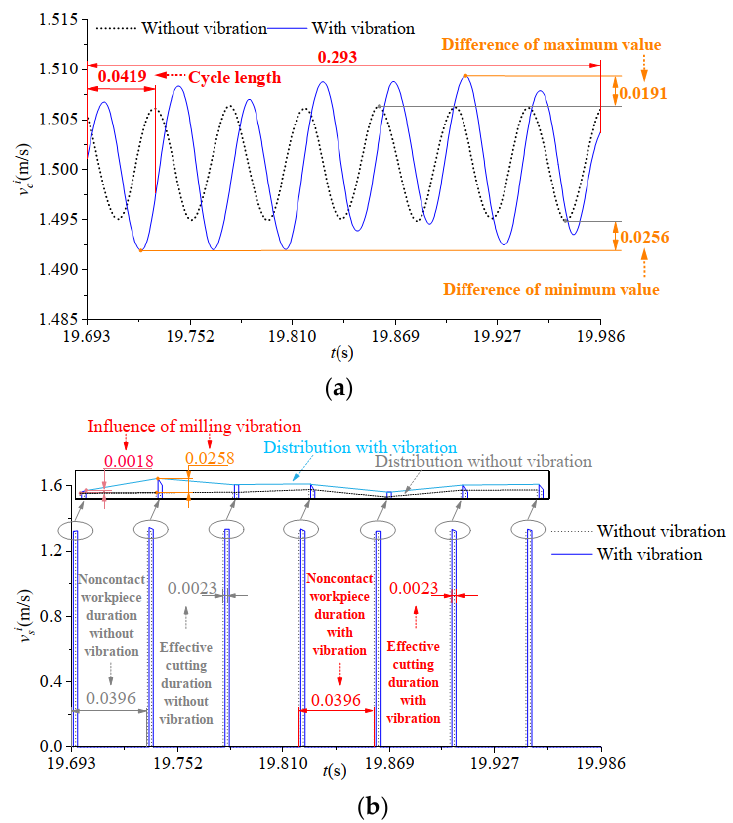
Figure 9. Instantaneous cutting velocity and shear direction velocity of selected cutting edge point. ( a ) Instantaneous cutting velocity; ( b ) shear direction velocity.